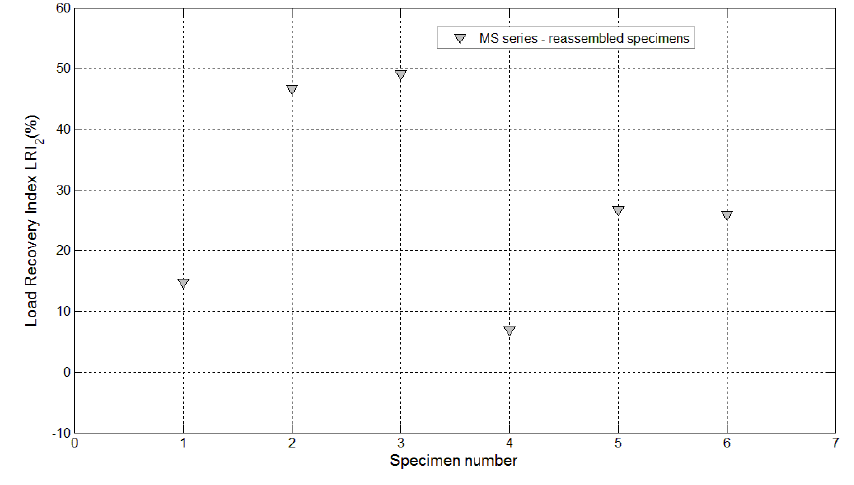
Figure 19. Load vs . CMOD curves for specimens with maccheroni (MS series) reassembled after complete failure and re-loaded after the second self-healing process.